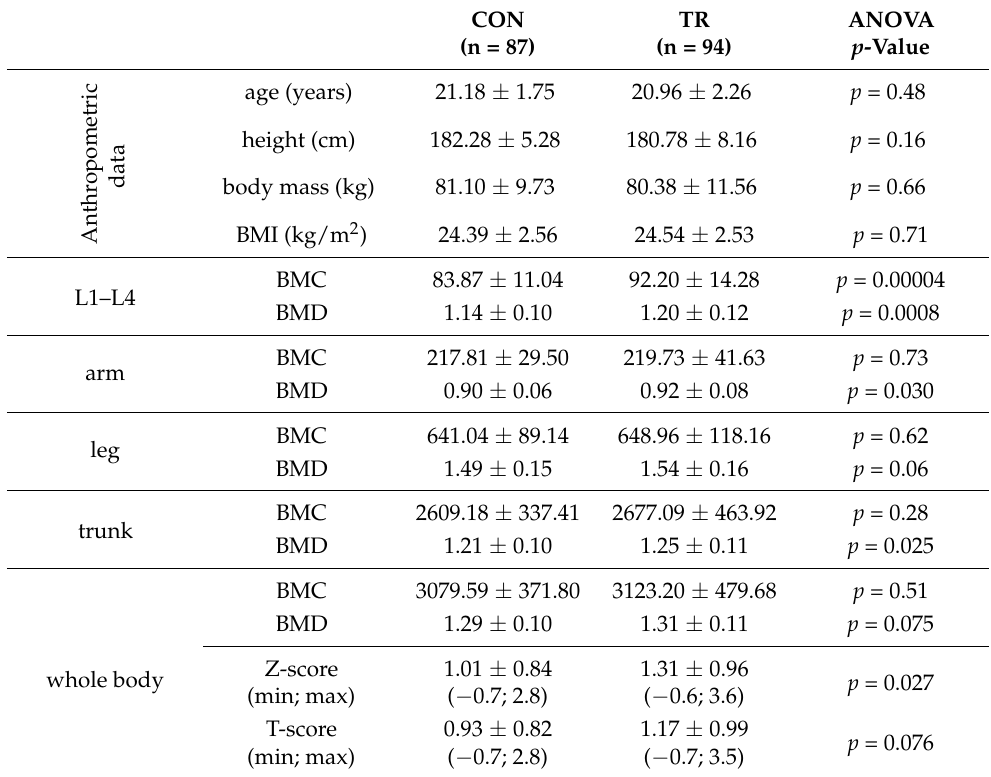
Table 1. Anthropometric data, regional and total body bone mineral content (BMC) (g) and bone mineral density (BMD) (g/cm 2 ) in the control group (CON, n = 87) and in the trained group (TR, n = 94).